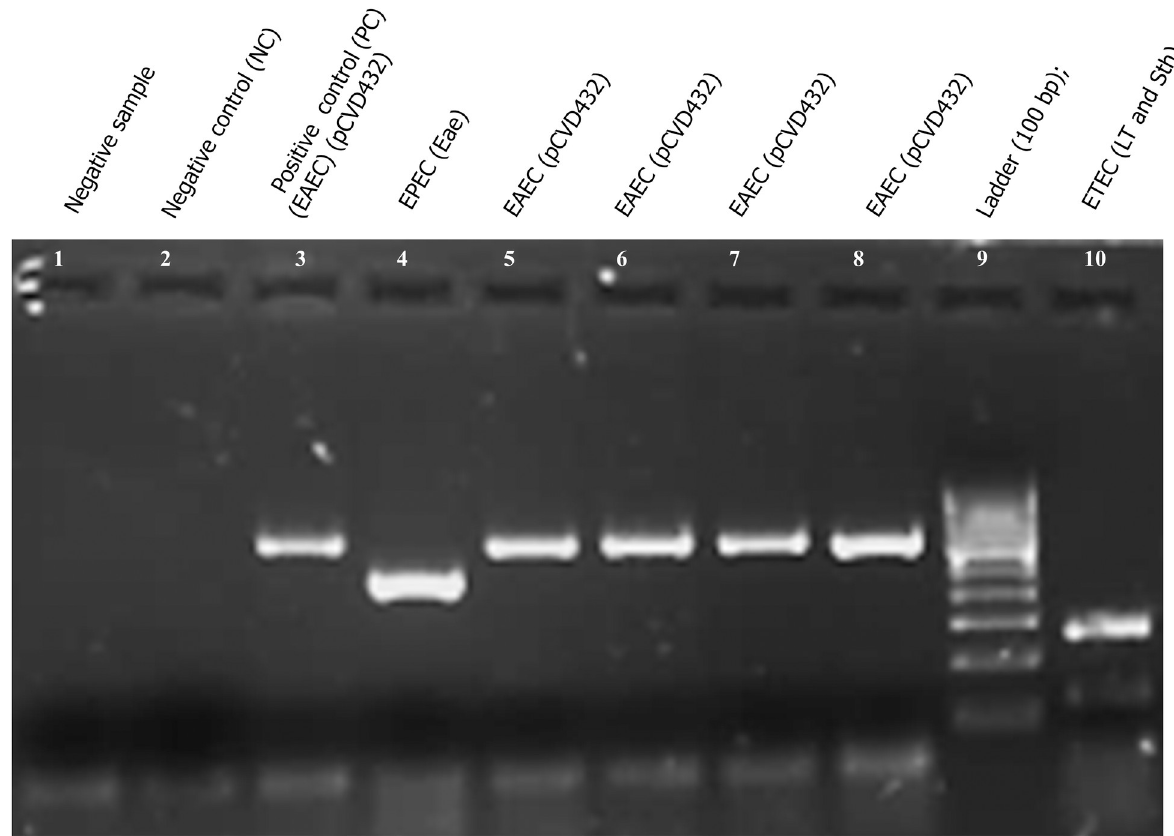
Fig 3. A representative gel electrophoresis profile of different DEC using M-PCR. lane 1, negative sample; lane 2, negative control (NC); lane 3, positive control (PC) EAEC (pCVD432); lane 4, EPEC (Eae); lane 5, EAEC (pCVD432); lane 6, EAEC (pCVD432); lane 7 EAEC (pCVD432); lane 8, EAEC (pCVD432); lane 9, ladder (100 bp); and lane 10, ETEC (LT and Sth).